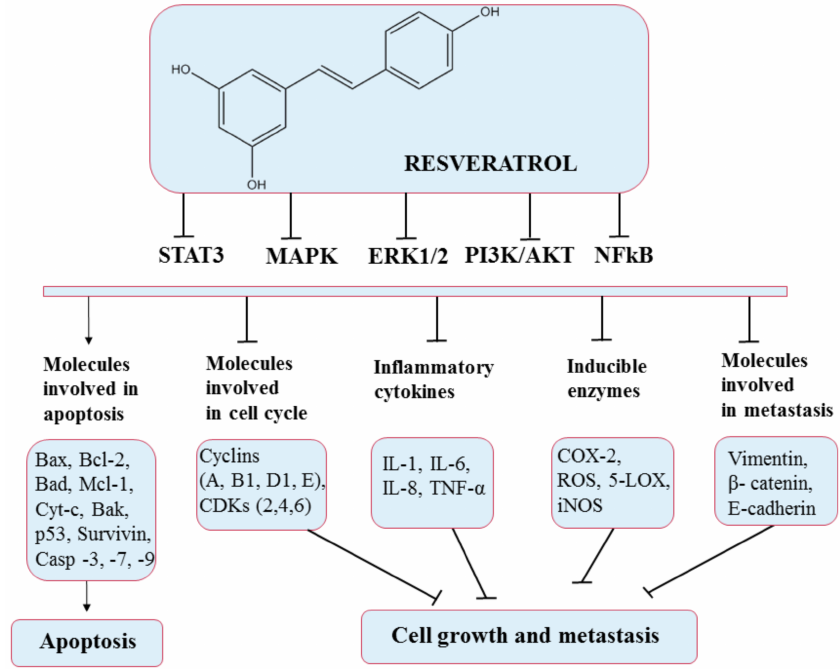
Figure 8. Chemical structure of resveratrol and its mechanism of action through different molecular targets that result in apoptosis or growth suppression and metastasis of